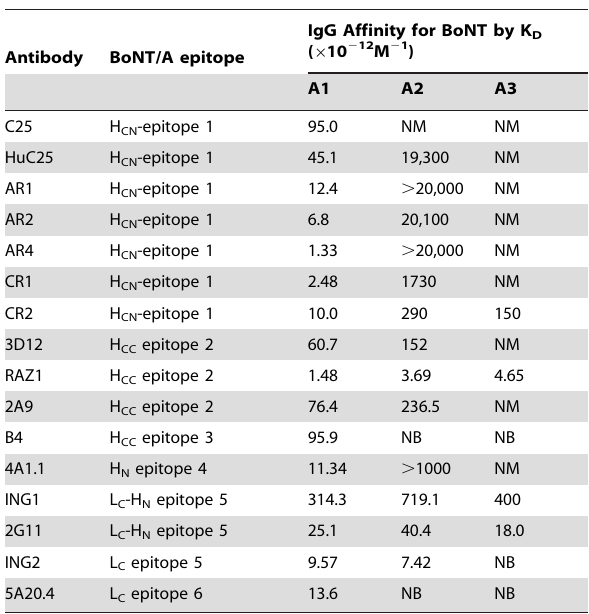
Table 1. A list of mAbs to BoNT/A with their epitopes and affinities for BoNT/A1, A2, and A3 as measured by dissociation rates (K D